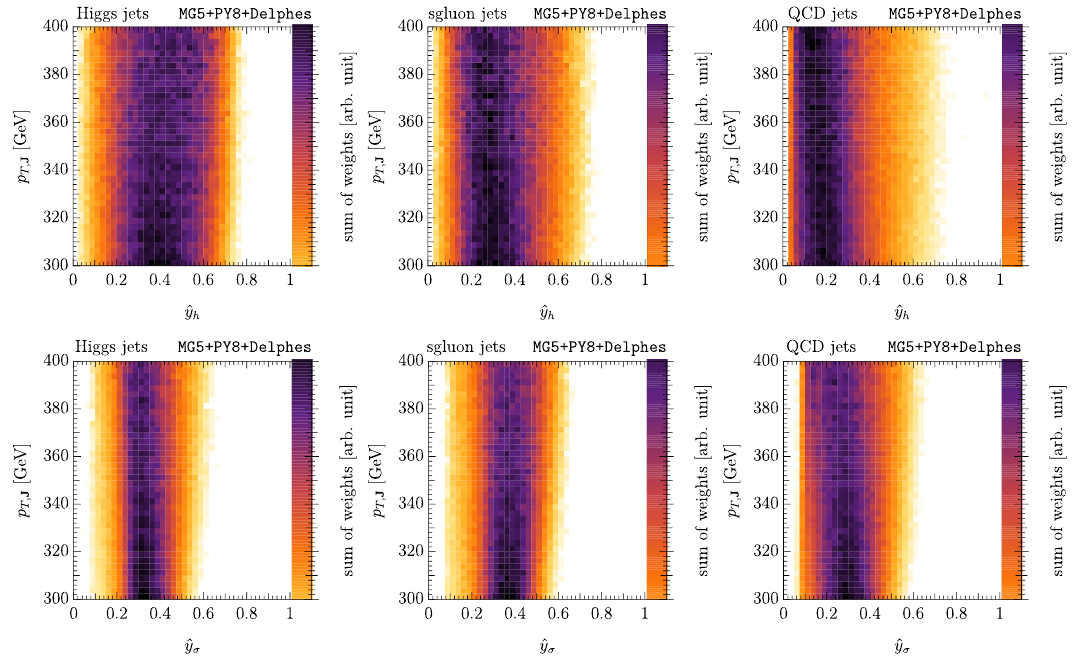
Figure 20 . Validation of the p T -bias removal on the training samples. Each row is a conditional probability density on a given p T; J range, i.e., the sum of each row is 1. Upper (lower) panel displays the conditional probability density histograms of the predicted class vector ^ y h (^ y (cid:27) ) for the Higgs jet (left), sgluon jet (center), and QCD jet